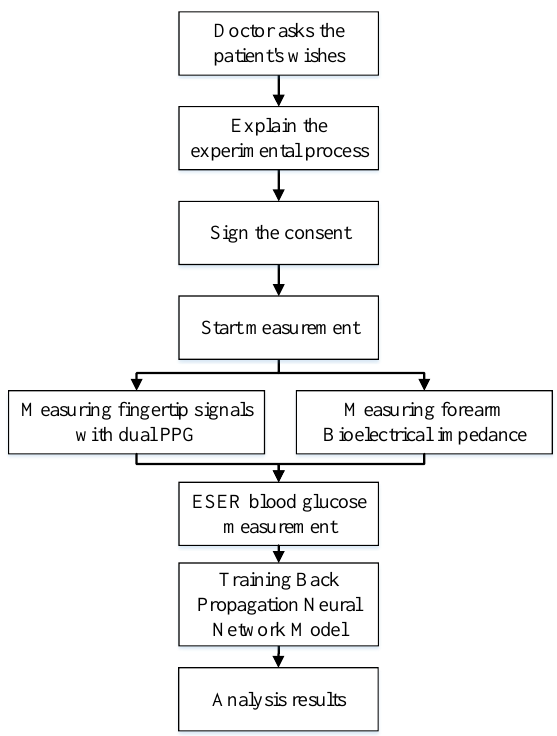
Figure 3. Flow chart of the clinical trial.